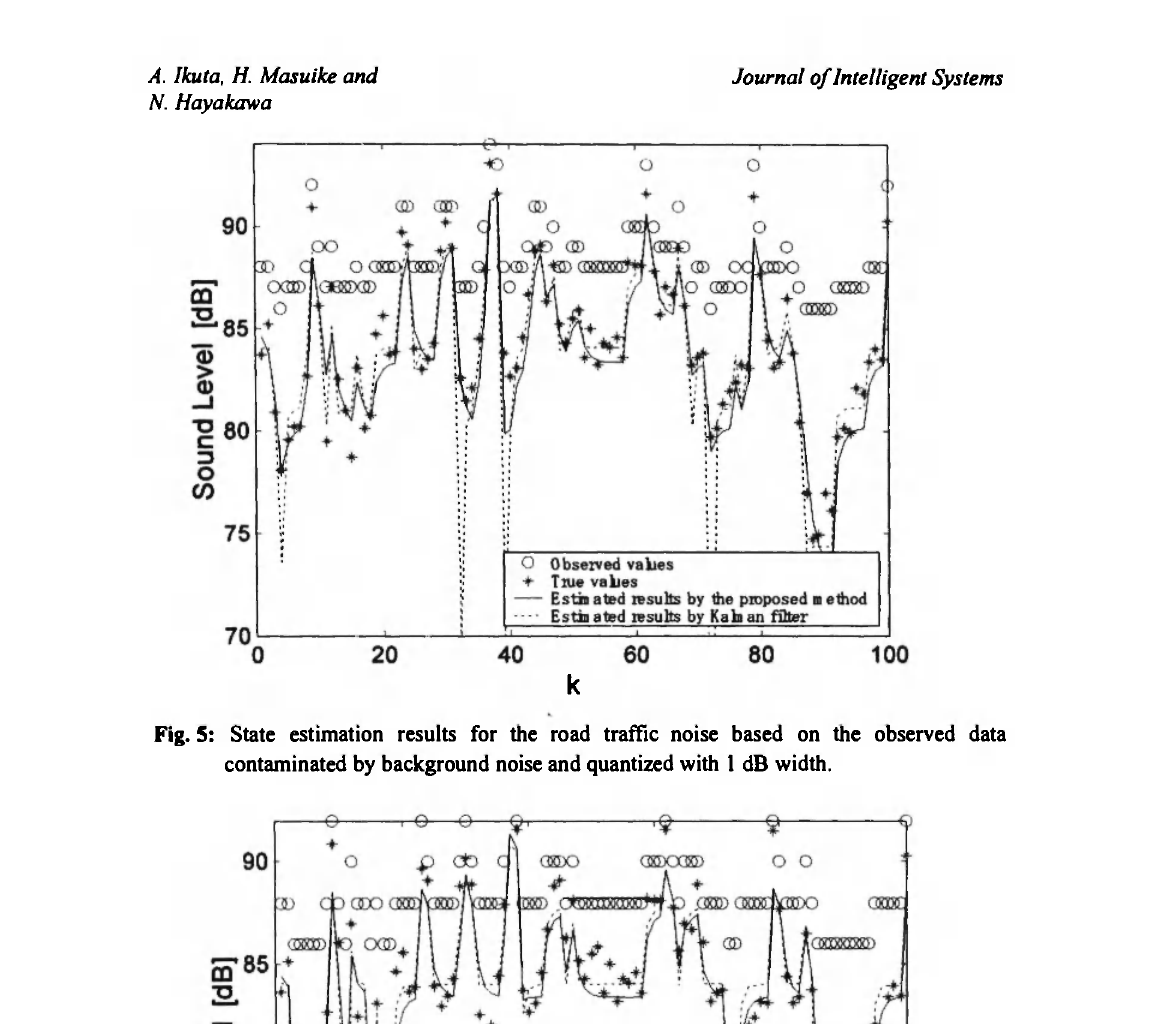
Fig. 5: State estimation results for the road traffic noise based on the observed data contaminated by background noise and quantized with 1 dB width.